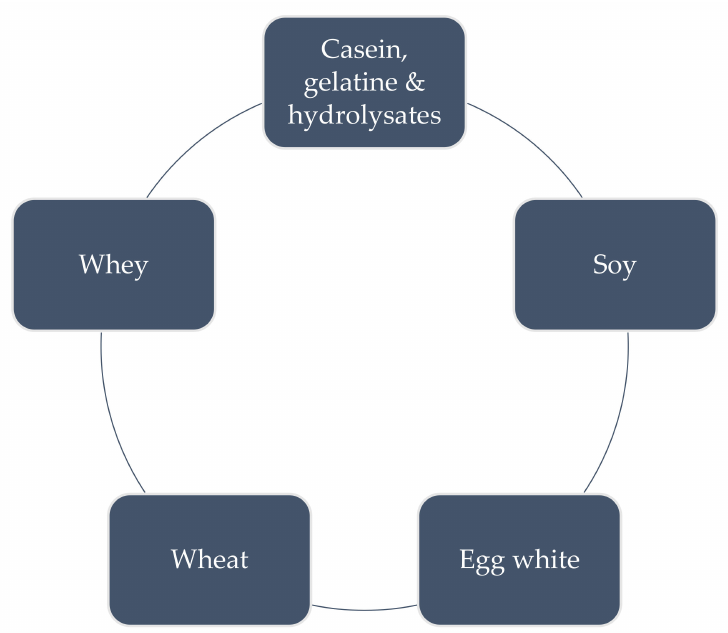
Figure 4. The most common sources of protein in food